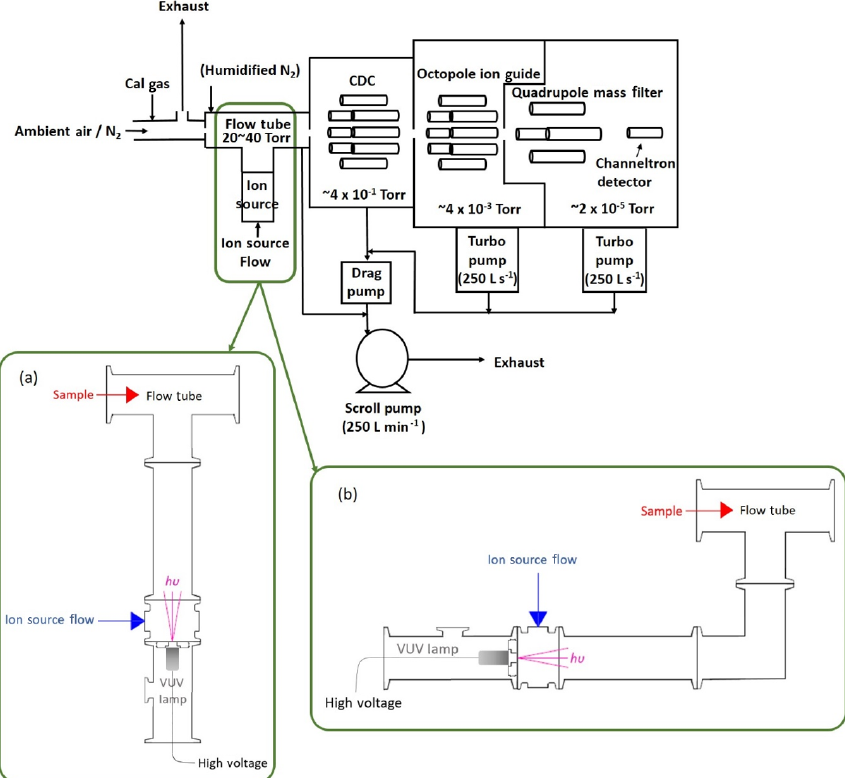
Figure 1. Diagram of the I − -Q-CIMS system with a VUV-IS in two different configurations. Configuration (a) provides the most direct route for the generated ions but also directly illuminates the flow tube. Configuration (b) shields the flow tube from the VUV photons by inserting a QF 40 elbow between the photoionization region and the flow